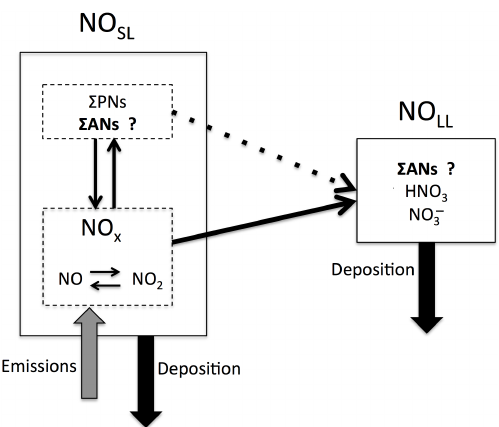
Figure 1. A schematic representation of the chemistry of NO SL and NO LL , showing the typical components of both